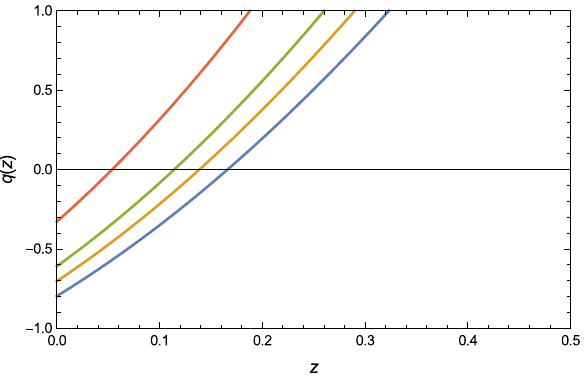
Fig. 8 Evolution of the scale factor with cosmic time. The various colors take on the following values of the mass term. Blue: M = 1, yellow: M = 3, green: M = 5, and red: M = 7